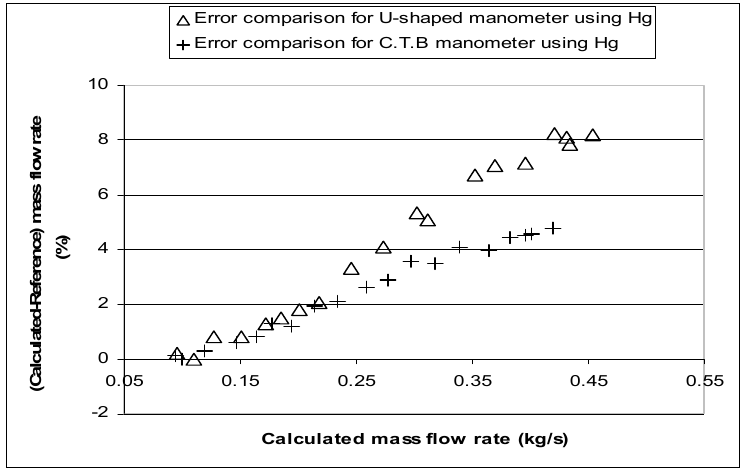
Figure 6. Error analysis comparison between mass flow rates